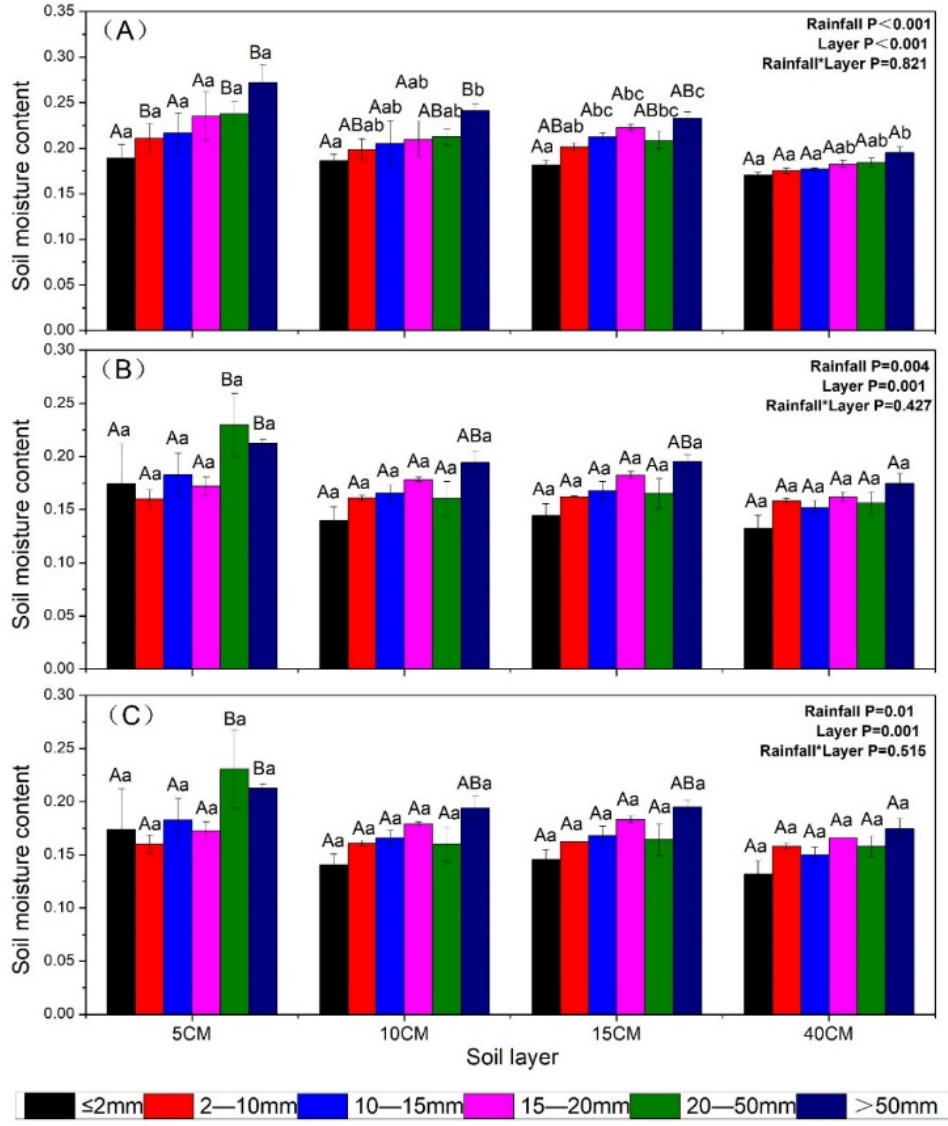
Figure 7. Initial moisture content in grassland, Q. acutissima , and C. lanceolata following different rainfall intensities. (Note: Upper case letters indicate significant differences between different soil layers under the same rainfall intensity ( p < 0.05); lower case letters indicate significant differences between different rainfall intensities of the same soil layer ( p < 0.05); ( A ): grassland ; ( B ): Q. acutissima ; ( C ): C. lanceolata ; land types: p < 0.001).